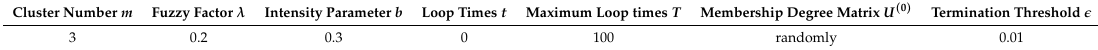
Table 1. Parameters of the image segmentation method.